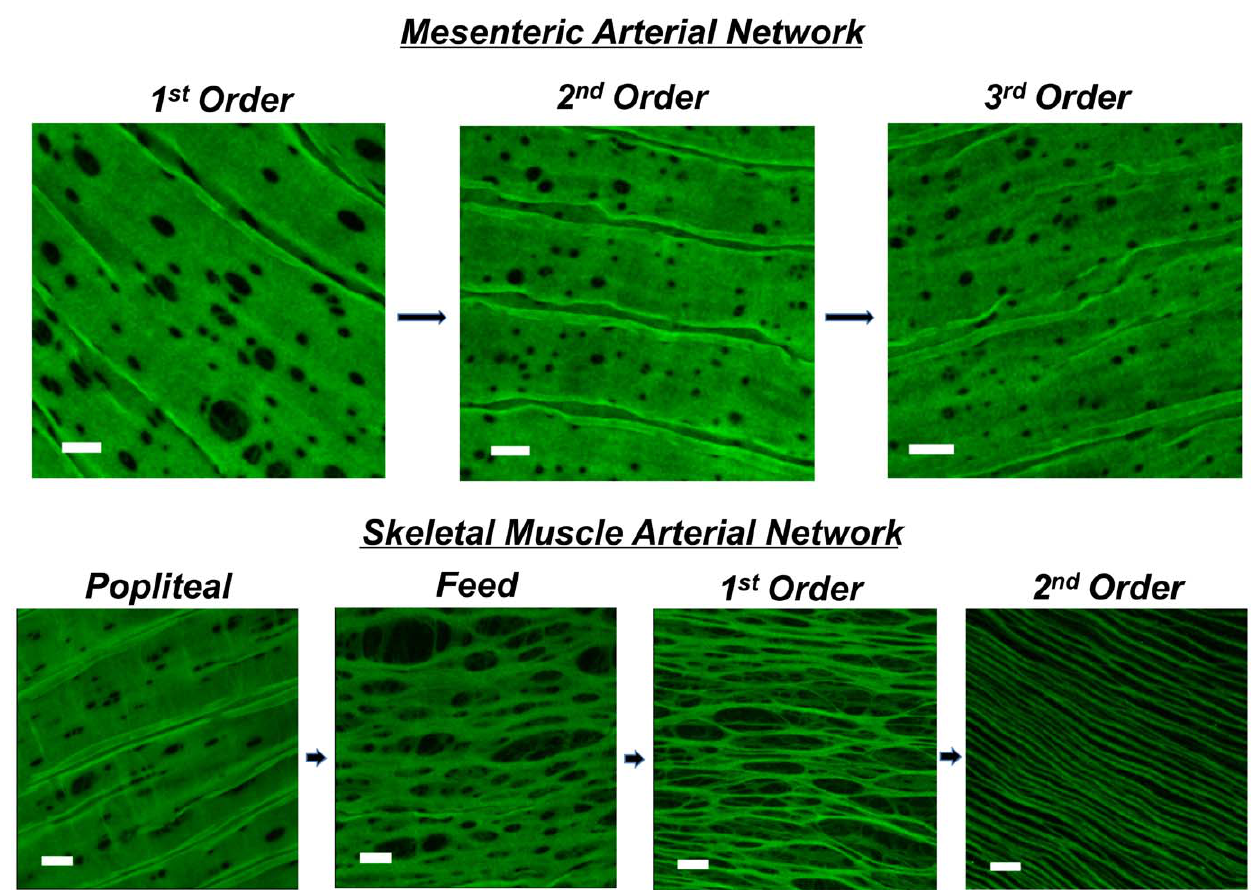
Figure 2. Internal elastic lamina in mesenteric vs. skeletal muscle arteries. Autofluorescence (green) of the internal elastic lamina (IEL) of mesenteric first, second, and third order arteries (top), and skeletal muscle popliteal, feed, first and second order arteries (bottom). Note that areas without green demonstrate lack of IEL, indicating fenestration and area of myoendothelial space. Bar=10 m m.